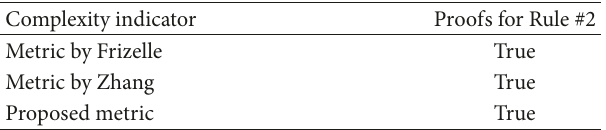
Table 6: Proofs of Rule #2.